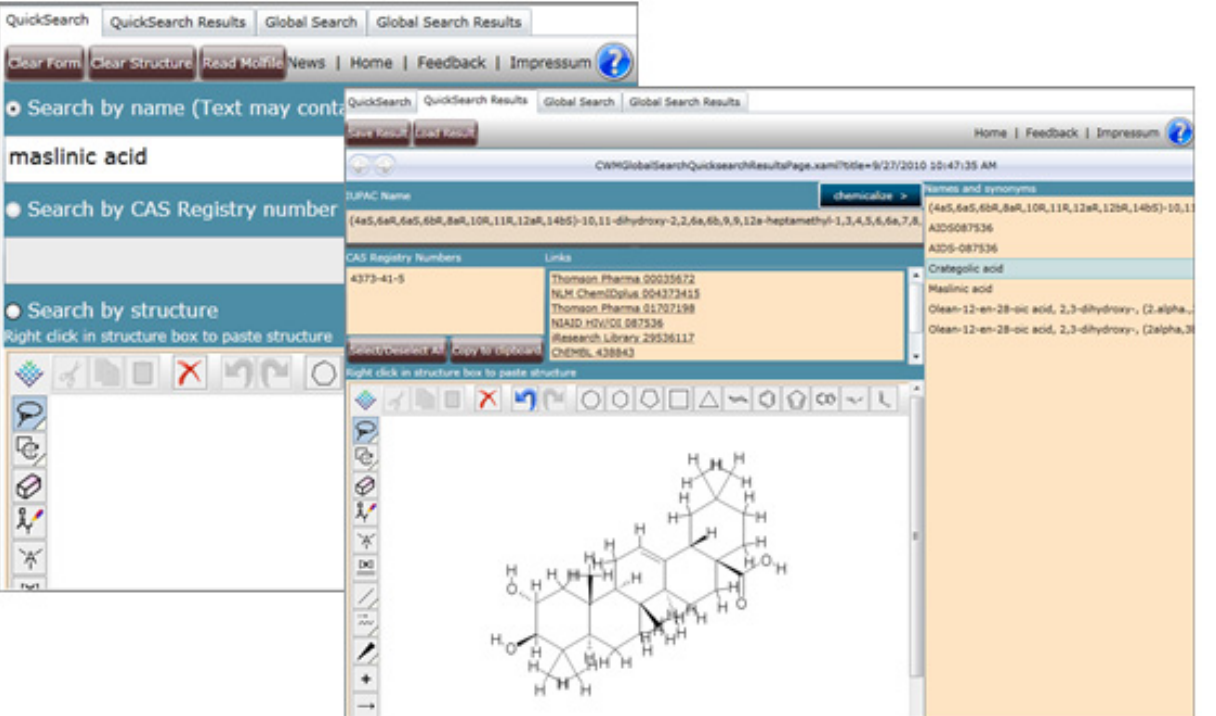
Figure 1. The CWM Global Search user interface Quick Search — synonym search for maslinic